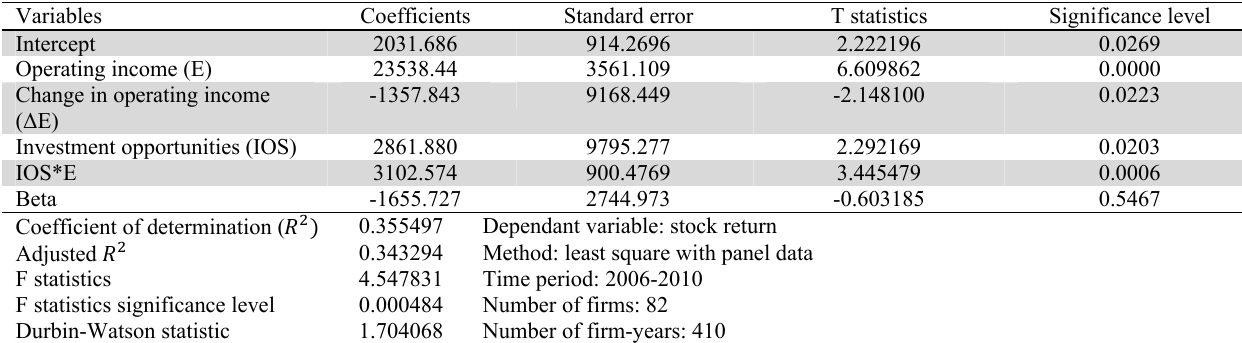
Model estimation